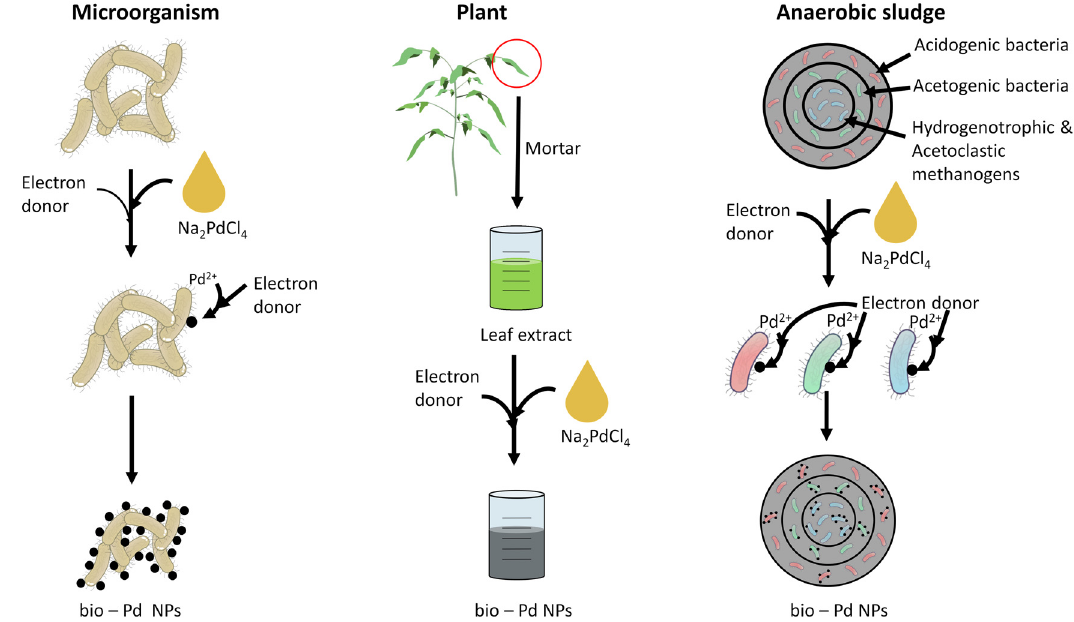
Figure 2: Overview of the production methods for bio - Pd NPs by using microorganisms, plants, and anaerobic